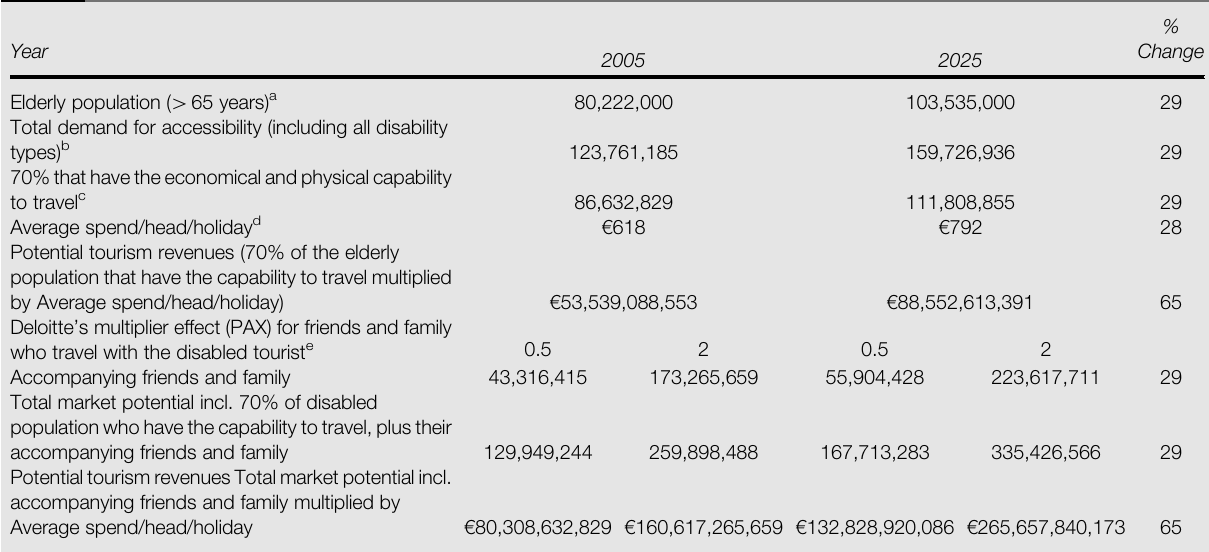
Table I Overview of the accessible tourism market value in Europe